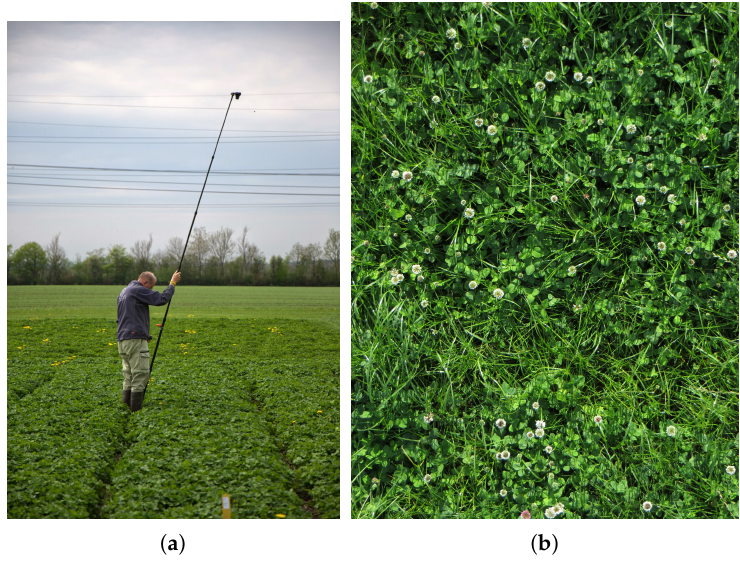
Figure 1. ( a ) Photo of how the images were captured. The digital camera was mounted on the end of the pole and facing down. ( b ) Example of captured image covering approximately 80 × 100 cm 2